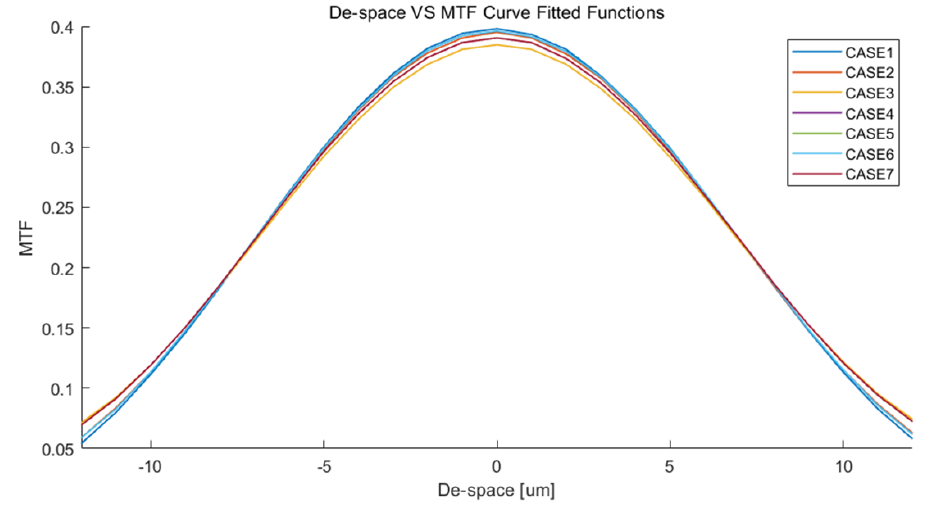
Figure 2. Relation of MTF to De-space, with respect to the Tilt.